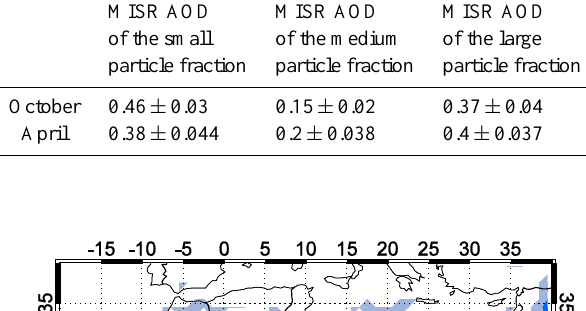
Fig. 7. AERONET AE observations over Cairo from April 2005 to March 2006. The vertical bars represent standard errors.